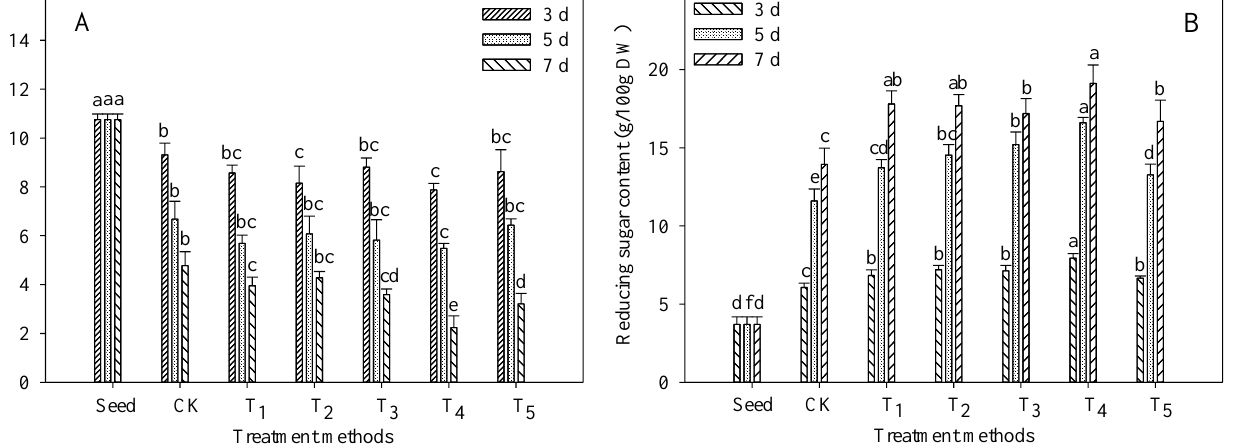
Figure 3. Effect of exogenous additives on soluble sugar and reducing sugar contents of TB sprouts. (A) Soluble sugar content (g/100 g DW); (B) Reducing sugar content (g/100 g DW). Differ- ent lowercase letters indicate significant statistical difference ( p < 0.05).